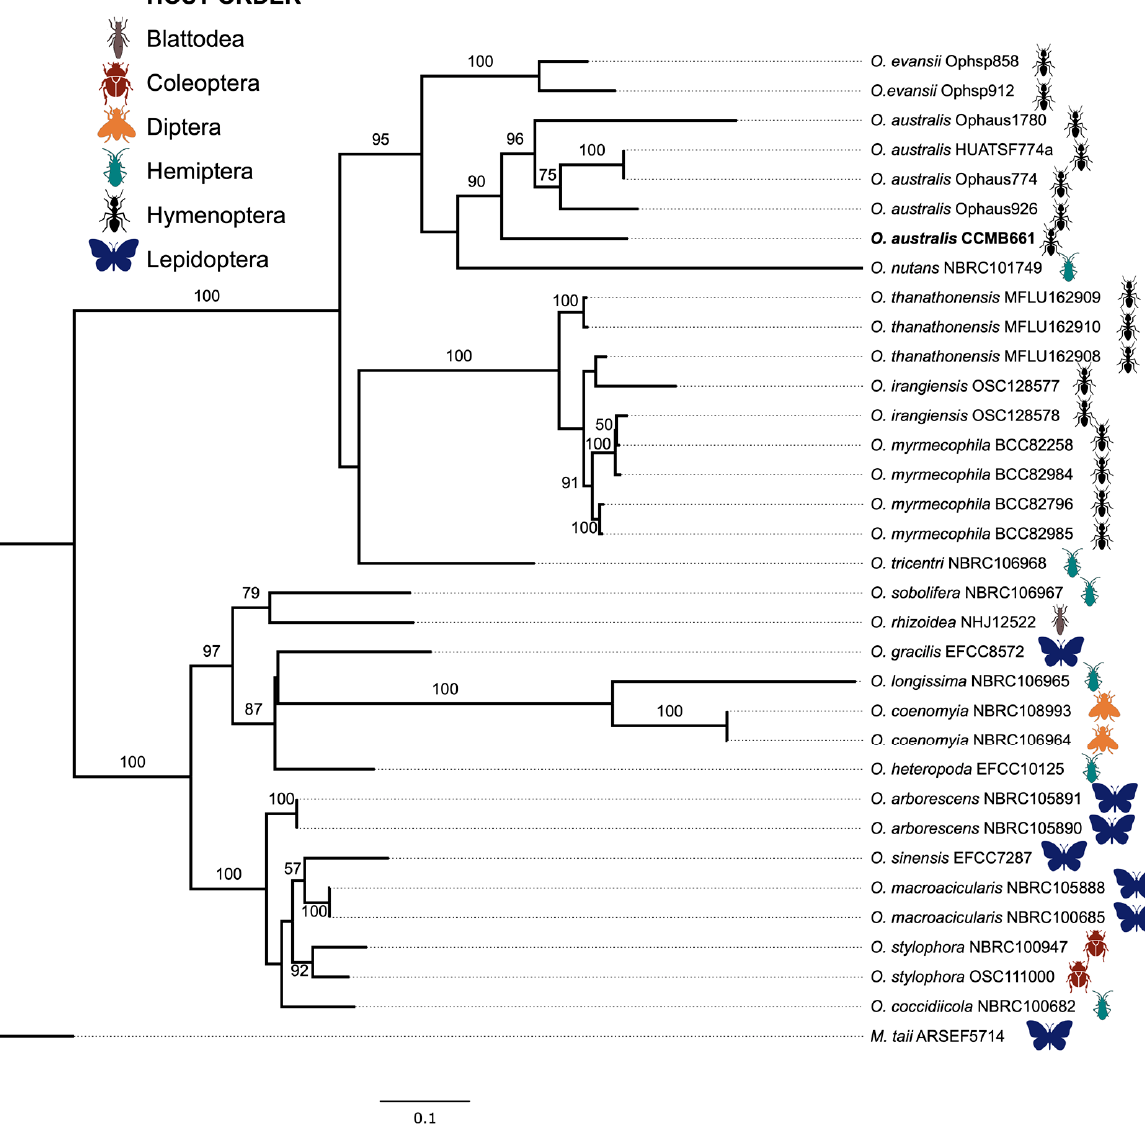
Figure 4. Phylogenetic tree showing the position of the isolate Ophiocordyceps australis CCMB661 obtained parasitizing the ant Neoponera curvinodis Forel, 1899, compared to different species of the genus Ophiocordyceps . Analysis was based on concatenated sequences of ITS, LSU, and TEF markers. Maximum Likelihood (RAxML) tree was built using the GTR-GAMMA nucleotide substitution model, and the values on branches indicate the percentage of bootstrap based on 1.000 replicates. Bars show nucleotide substitutions per site. The tree includes a total of 31 ITS, 34 LSU, and 34 TEF sequences. We included 33 Ophiocordyceps sequences from previous studies obtained from GenBank. The final alignment had 2.836 base pairs. Species from GenBank are followed by their strain codes. For each sequence included in this phylogenetic analysis, we show the arthropod host order from which fungi were isolated (Blattodea = brown, Coleoptera = red, Diptera = orange, Hemiptera = green, Hymenoptera = black, Lepidoptera = blue). The fungus Metacordyceps taii was used as outgroup.